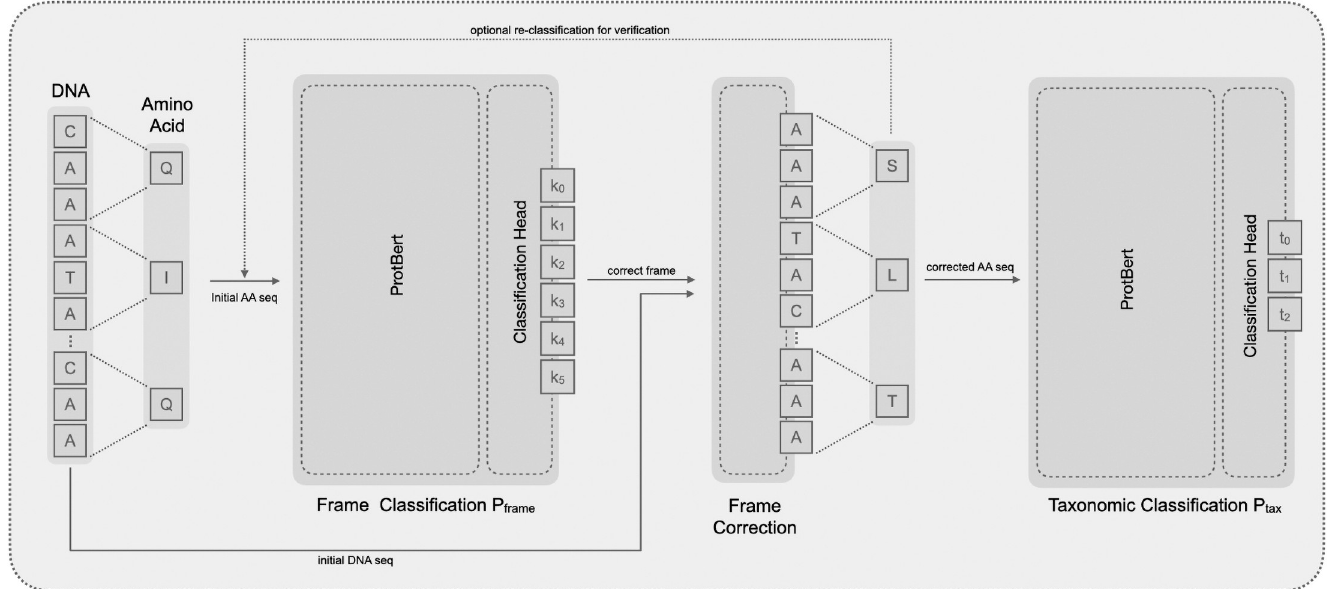
Fig 1. Overview of the complete neural network classification pipeline. The pipeline consists of four major blocks: (1) preprocessing NGS reads, (2) frame classification of NGS reads, (3) frame correction and translation of NGS reads, (4) taxonomic classification of amino acid sequence. The dotted arrow line shows an optional loop of the frame classification used for checking the frame correction block, as shown in Fig